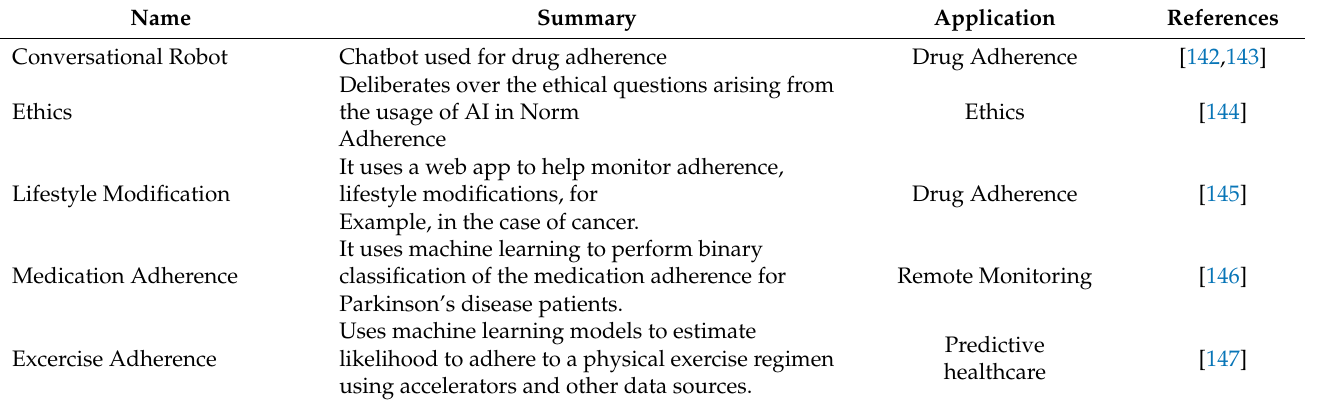
Table 6. Recent Works: AI in